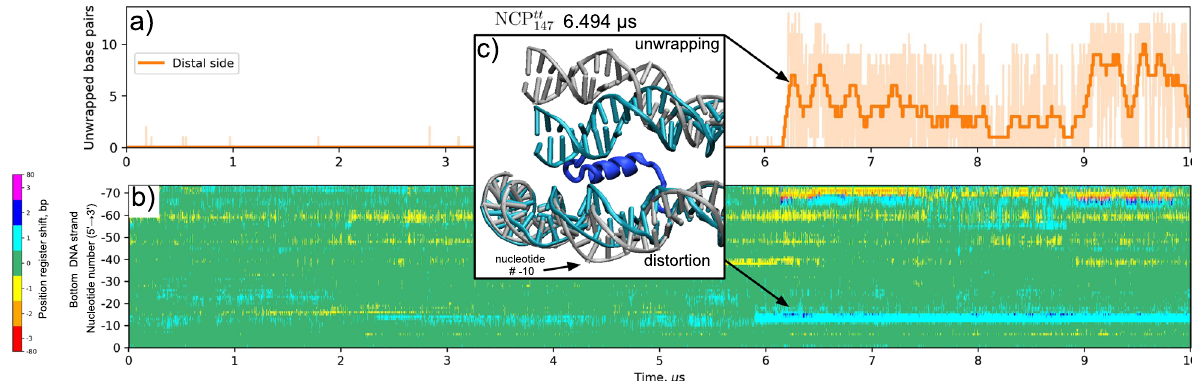
Fig. 9 Coupling between DNA unwrapping and DNA loosening near the dyad through H3-latch interactions. a DNA unwrapping as a function of simulation time of the distal DNA end in NCP tt 147 . b DNA distortions of the proximal half of the nucleosomal DNA visualized through the position register shift plot for the bottom DNA strand. c An MD snapshot showing the simultaneous DNA unwrapping, DNA distortion near the dyad, and detachment of the H3-latch from the inner DNA gyre near the dyad. Initial X-ray state is shown